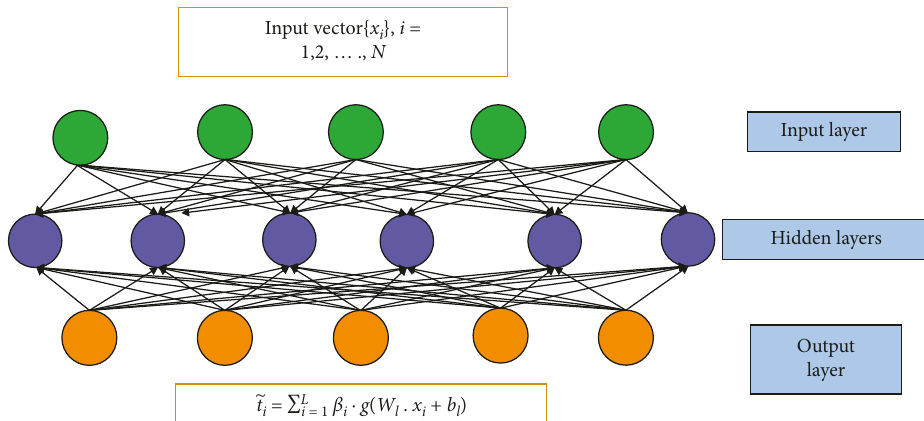
Figure 3: Paradigm of extreme learning machine